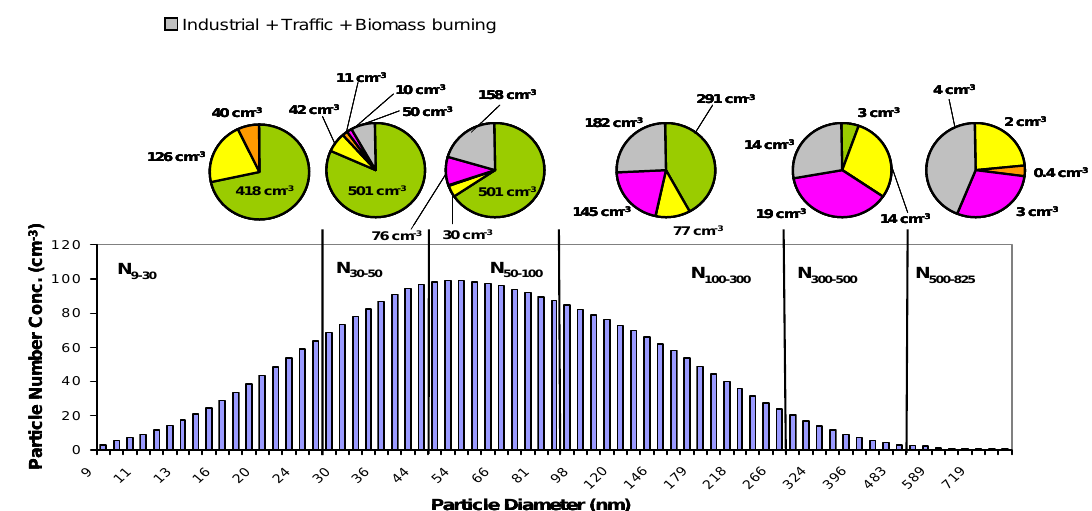
Fig. 10. Mean size distribution for particle concentrations (cm − 3 ) recorded at MSY and the corresponding contribution of each PC to the particle number concentration for various size groups (N 9 − 30 , N 30 − 50 , N 50 − 100 , N 100 − 300 , N 300 − 500 , N 500 − 825 )